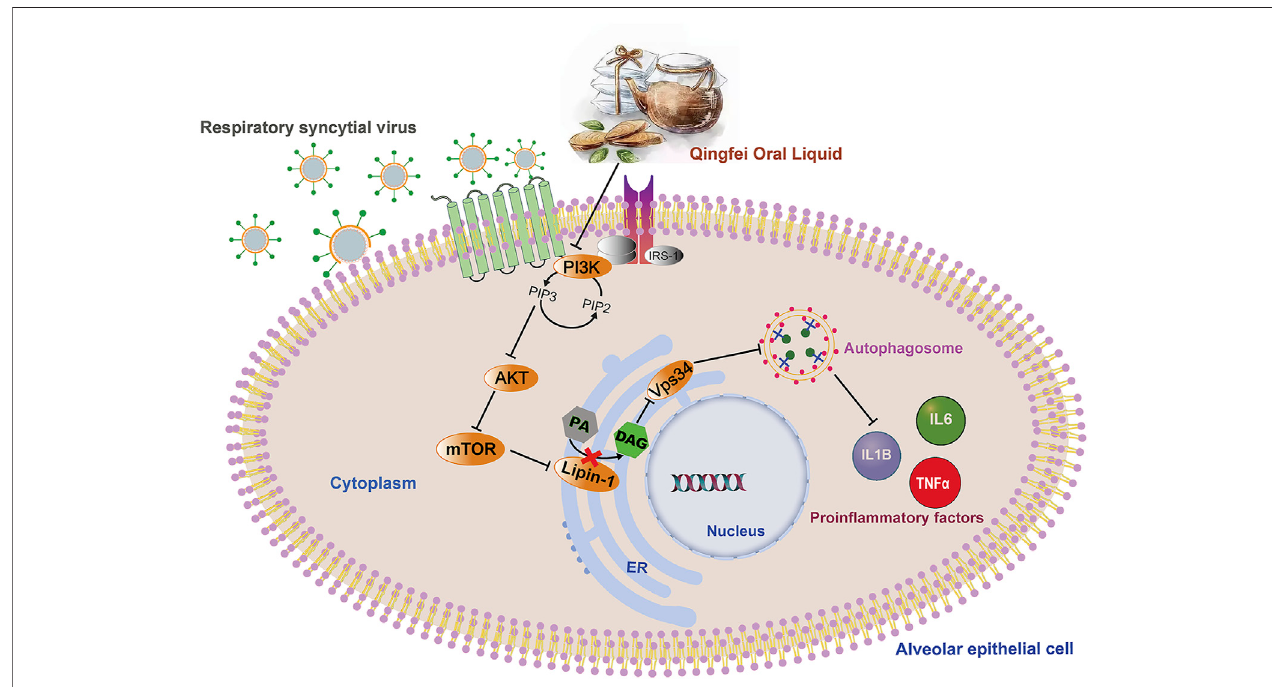
FIGURE 8 | Overall regulation mediated by QF in the treatment of RSV pneumonia. Abbreviations: QF, Qingfei oral liquid; RSV, respiratory syncytial virus.